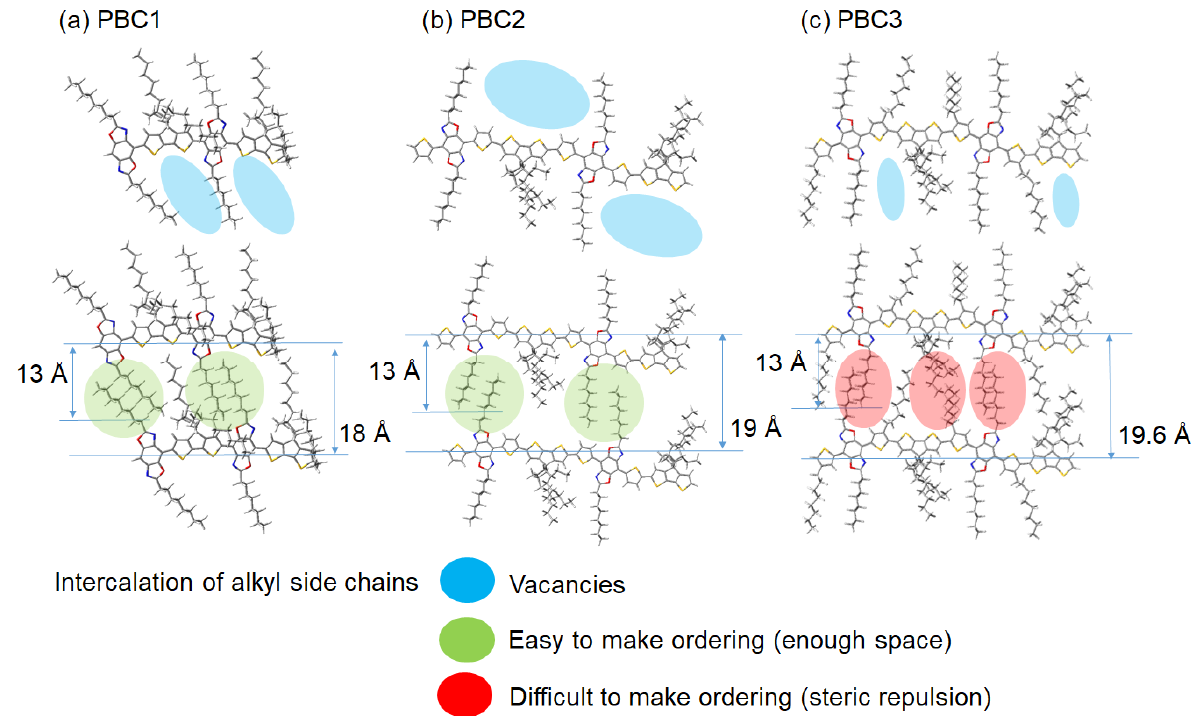
Figure 4. Optimized two repeating unit structures of ( a ) PBC1, ( b ) PBC2, and ( c ) PBC3 simulated by density ‐ functional theory (DFT) (B3LYP/6 ‐ 31G), and the expected lamellar ordering based on the DFT simulation and d ‐ spacing values.